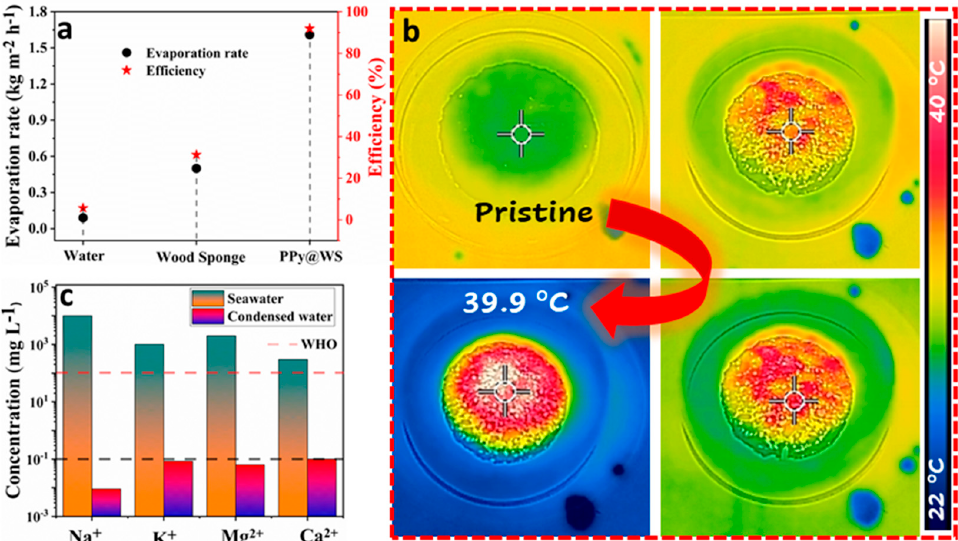
Figure 5. ( a ) Comparative evaporation rate and corresponded efficiencies of pure water, simple wood pulp sponge, and PPy@WS solar evaporator under 1 kW ∙ m − 2 . ( b ) IR images captured